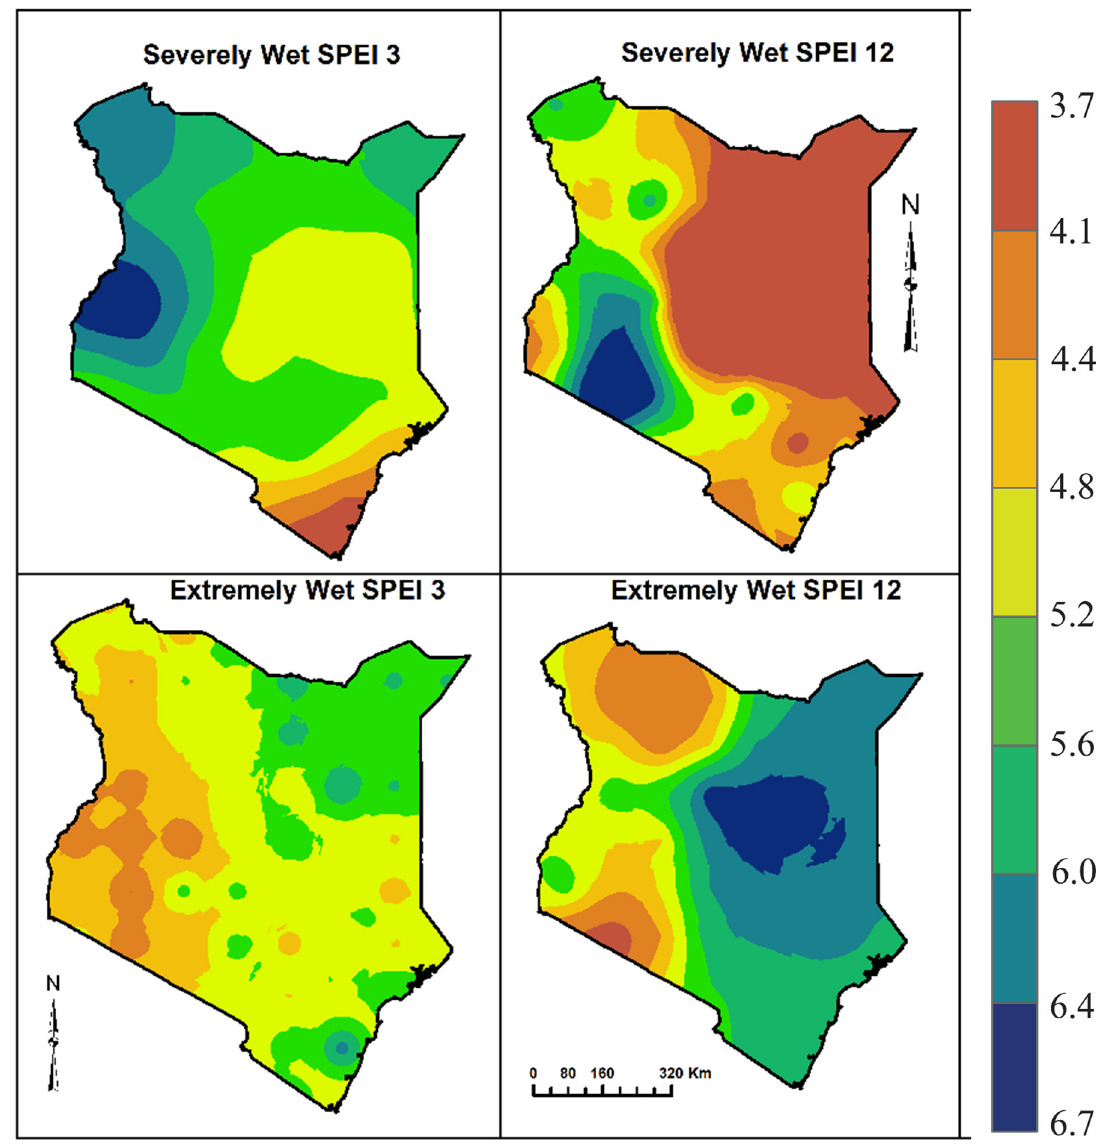
Figure 7. Frequency of severe ( top ) and extreme ( bottom ) wet events computed for the SPEI-3 and SPEI-12 month respectively over Kenya, 1981–2016.